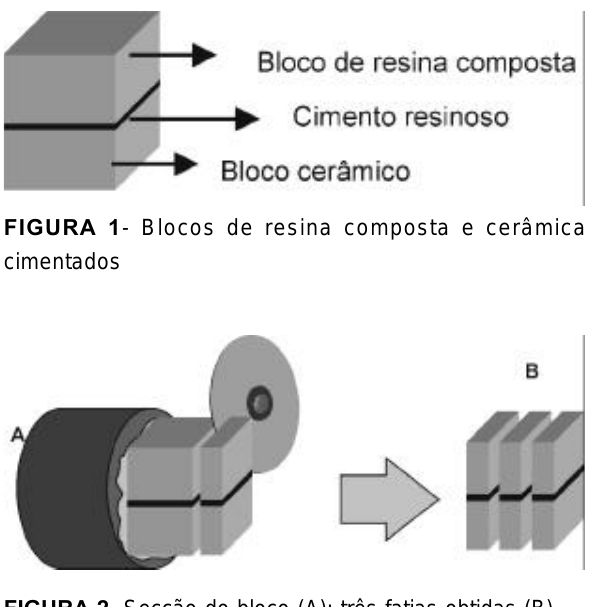
FIGURA 2 - Secção do bloco (A); três fatias obtidas (B)